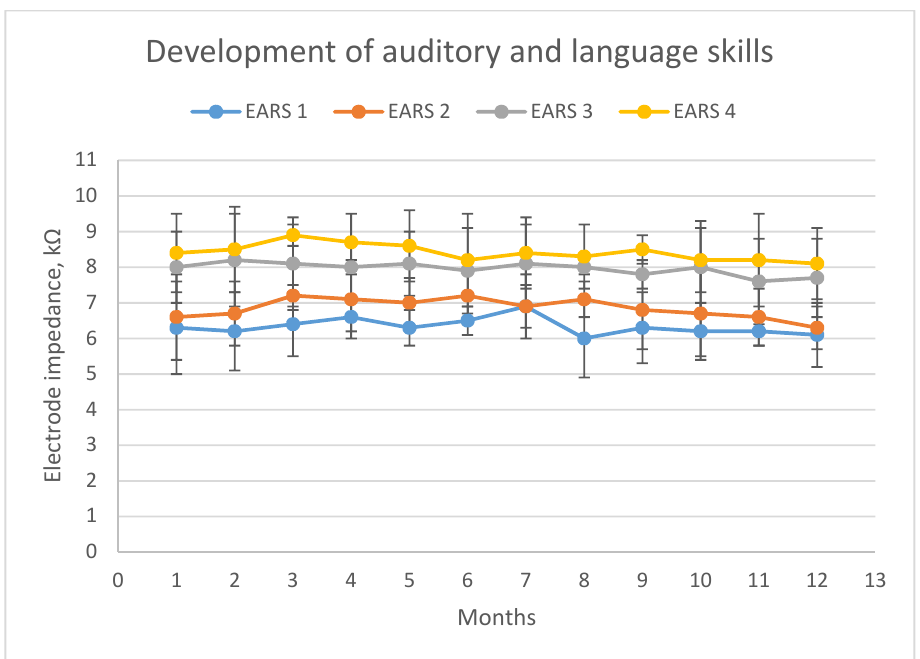
Figure 3. Evolution of EIVs in the first 12 months after activation compared between patients with different EARS scores. X axis: time after cochlear implantation in months. Y axis: Values of electrode impedance in k Ω . Blue line: patients with EARS Score 1. Red line: patients with EARS score 2. Grey line: patients with development score 3. Yellow line: patients with development score 4.